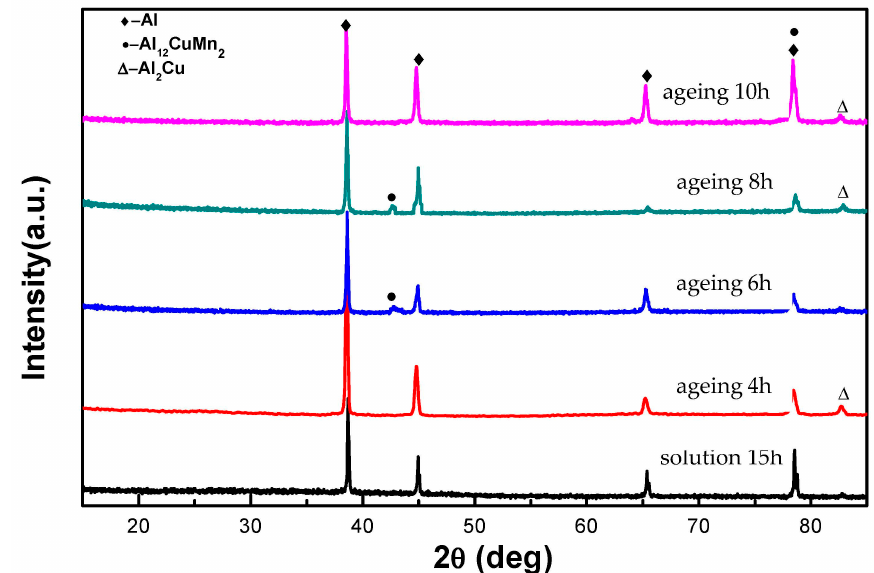
Figure 9. XRD patterns of squeeze-cast ZL205A under different heat treatments.